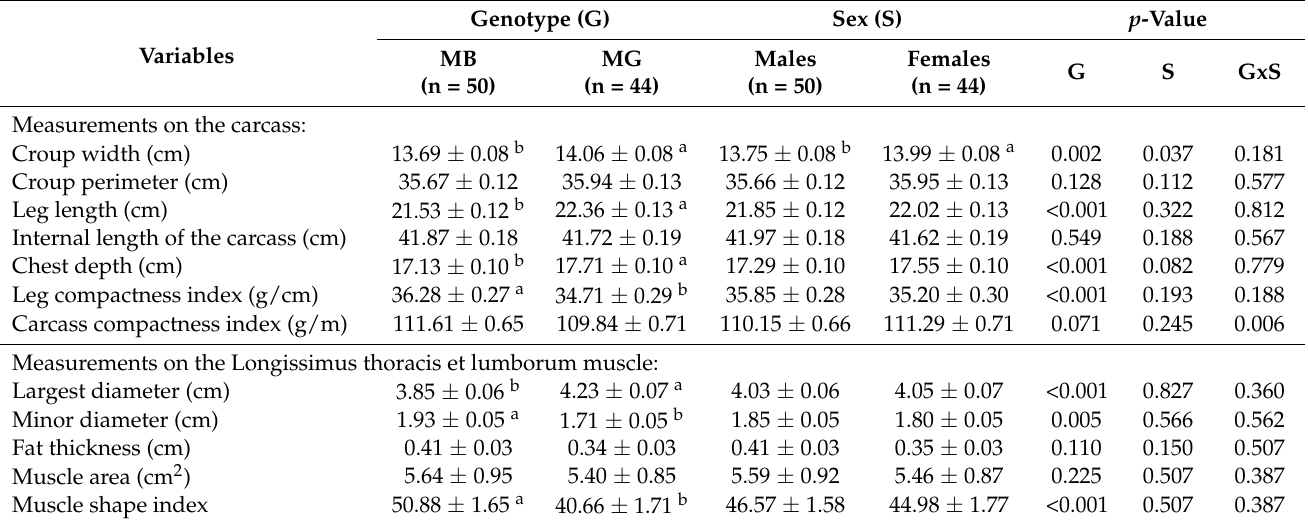
Table 3. Least-square means ( ± SE) for carcass measurements from kids according to genotype (purebred Murciano-Granadina (MG) or crossed with Boer (MB)) and